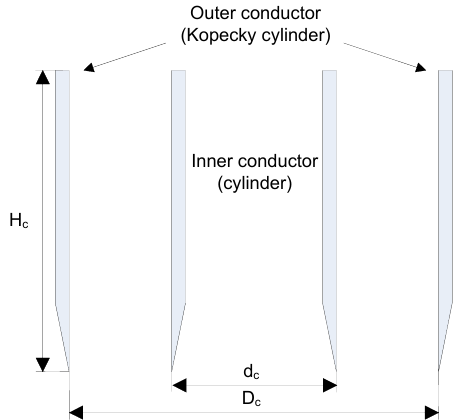
Figure 1. Cross-section of the Kopecky coaxial line – the central part of the proposed